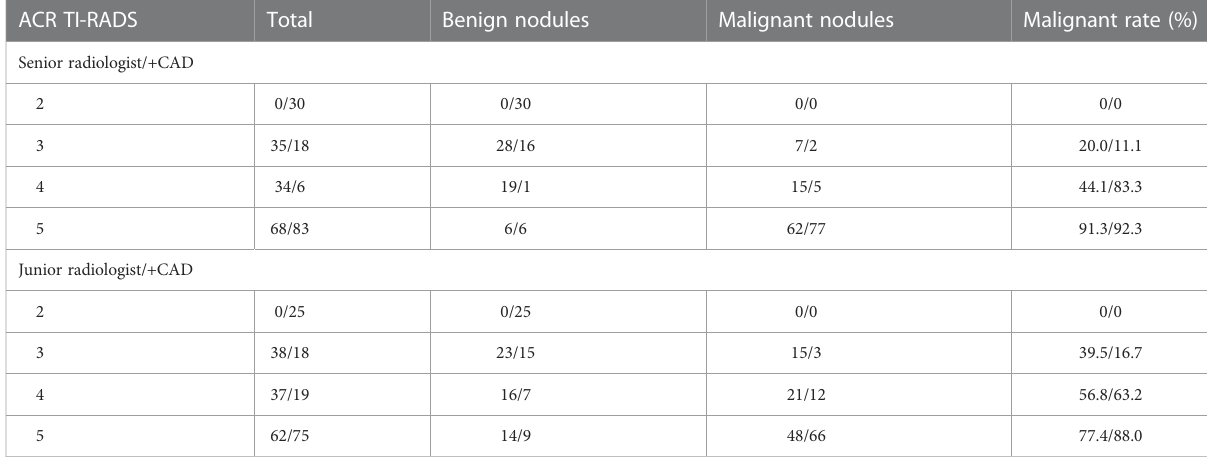
TABLE 4 Modi fi ed ACR TI-RADS according to the CAD system. ACR TI-RADS